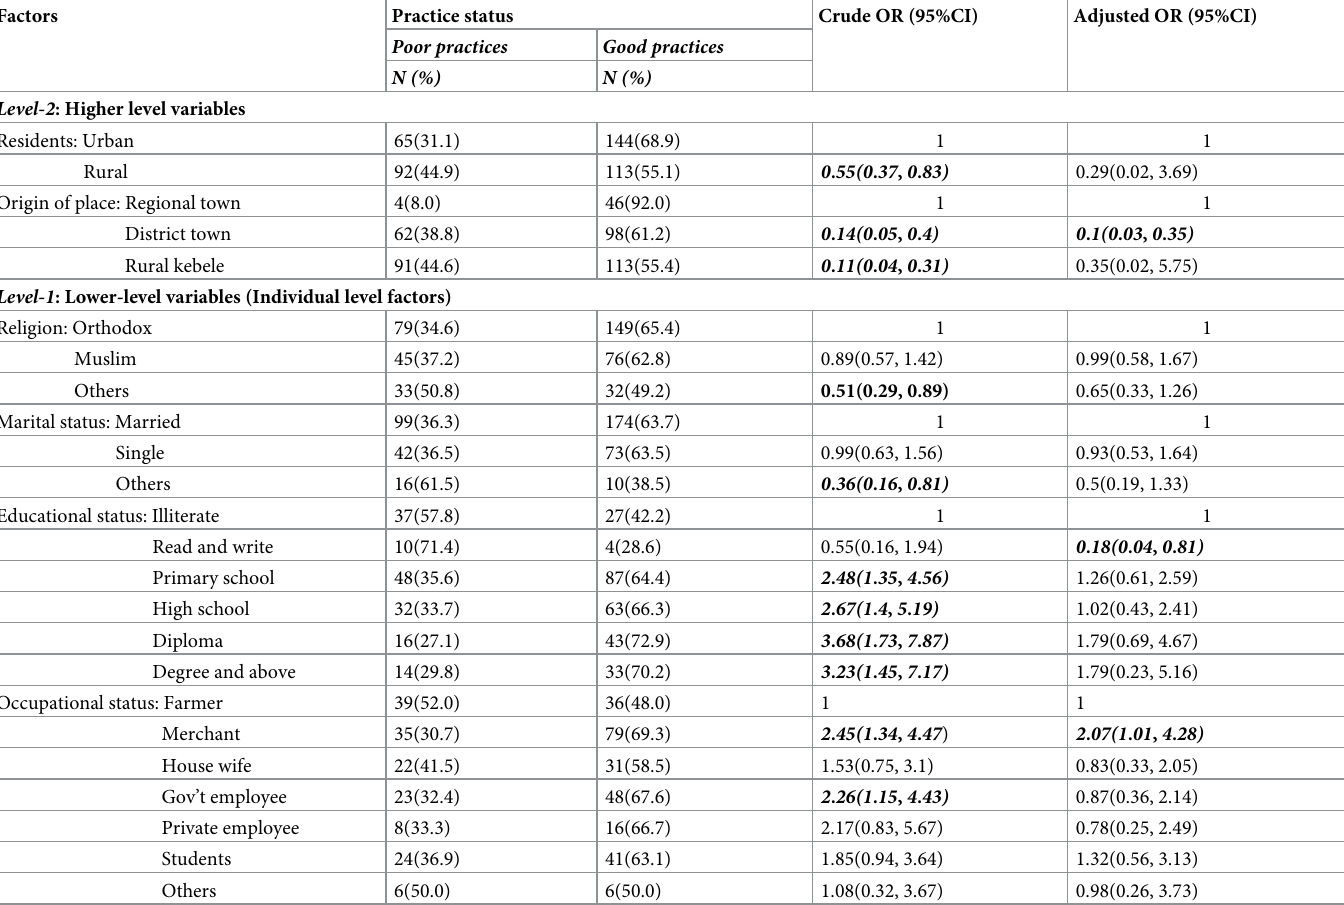
Table 5. Multilevel analysis of factors effecting practice of COVID 19 infections prevention strategies, among respondents, Benishangul Gumuz Region, Ethiopia